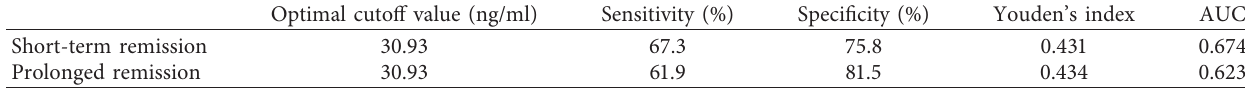
Table 6: ROC analysis of C-peptide AUC in remission